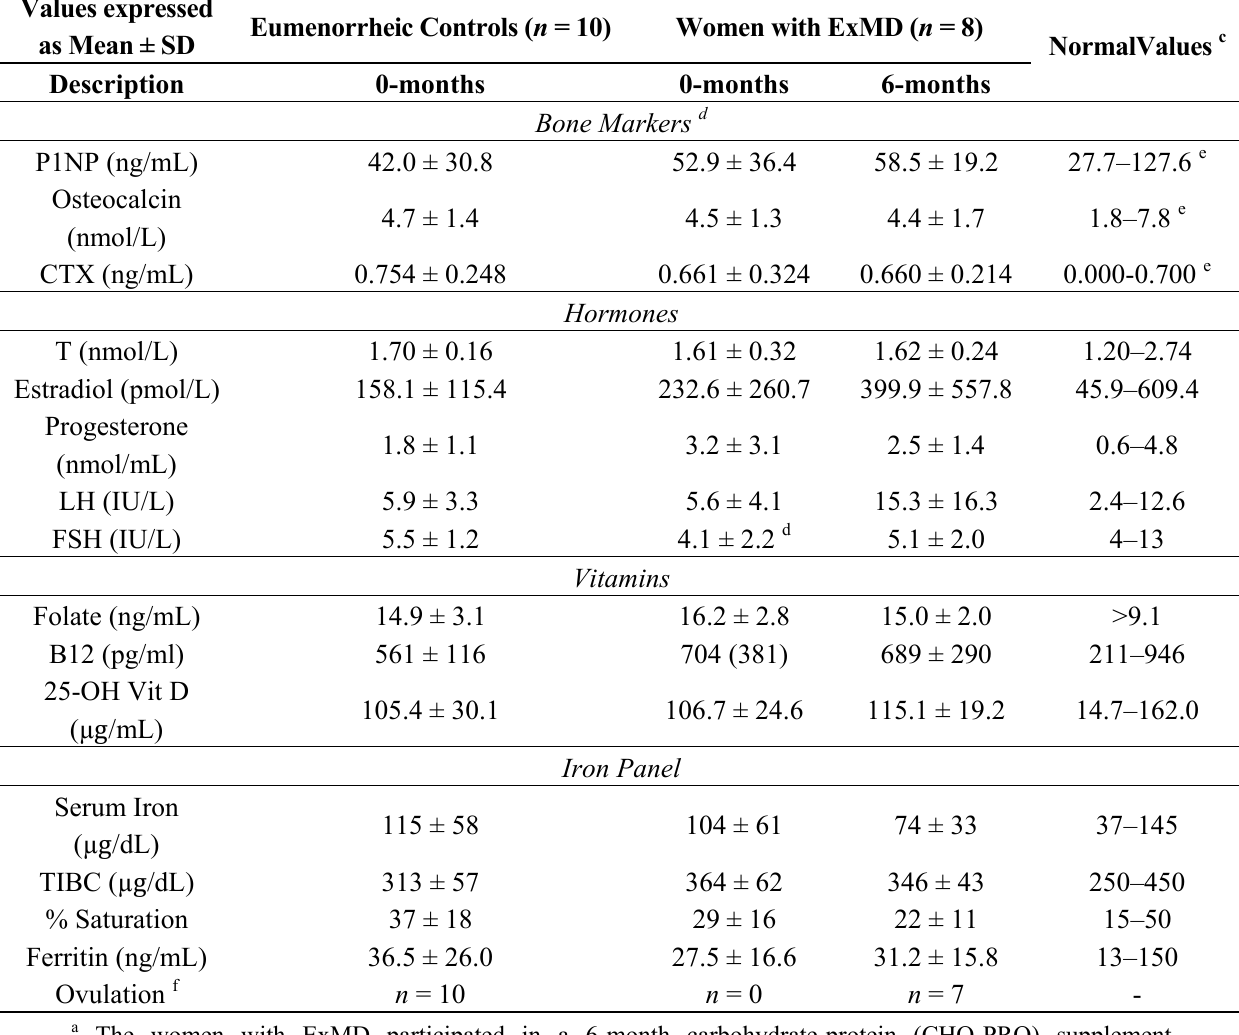
Table 4. Blood bone markers, hormones levels and ovulation status in athletes classified as eumenorrheic (Eumen) or with exercise-induced menstrual dysfunction (ExMD) before and after a 6-month dietary intervention a,b